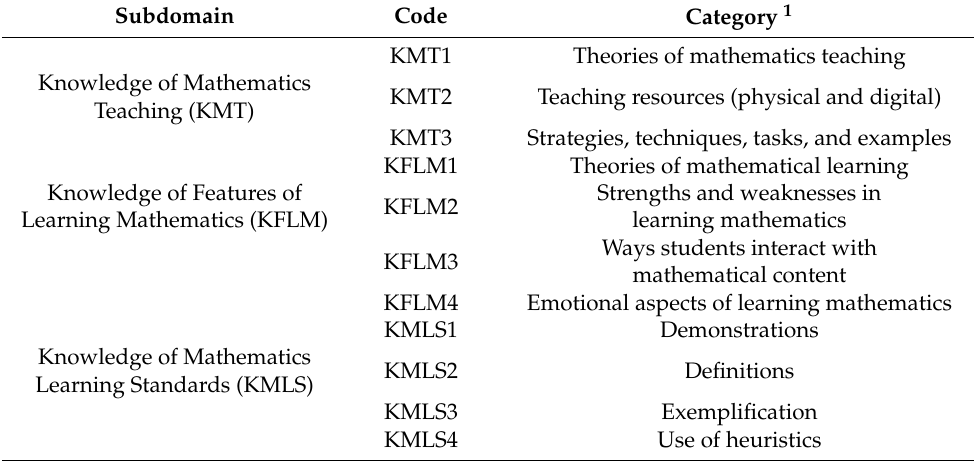
Table 2. Categories of the PCK